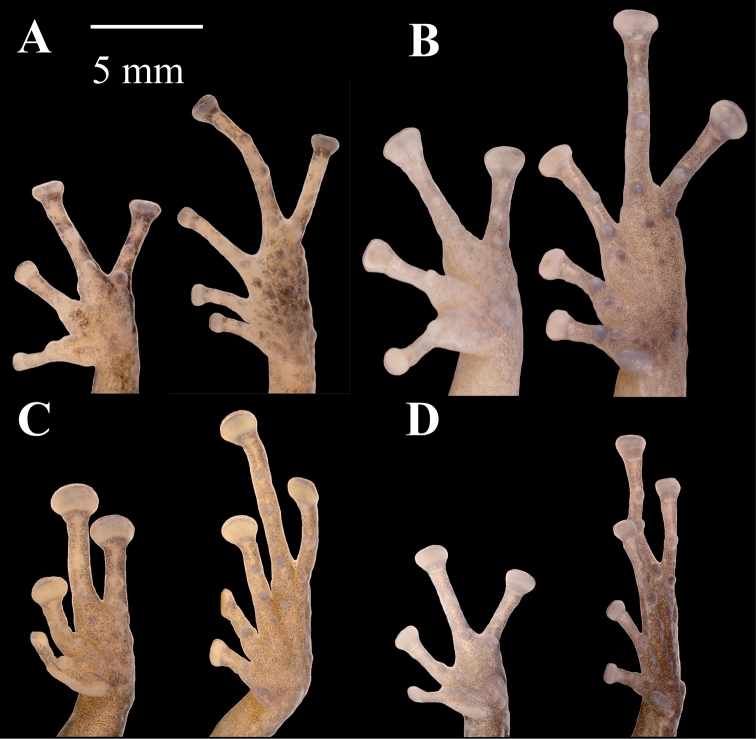
Palmar and plantar surfaces of Pristimantis
teslai sp. nov., Pristimantis
torresi sp. nov., Pristimantis
totoroi sp. nov., and Pristimantis
verrucolatus sp. nov. Photographs of hand and foot of the holotypes of the following species: APristimantis
teslai sp. nov.: QCAZ 46213, male BPristimantis
torresi sp. nov.: QCAZ 47342, female CPristimantis
totoroi sp. nov.: QCAZ 25105, male DPristimantis
verrucolatus sp. nov.: QCAZ 46982, male. All specimens are shown at the same scale.